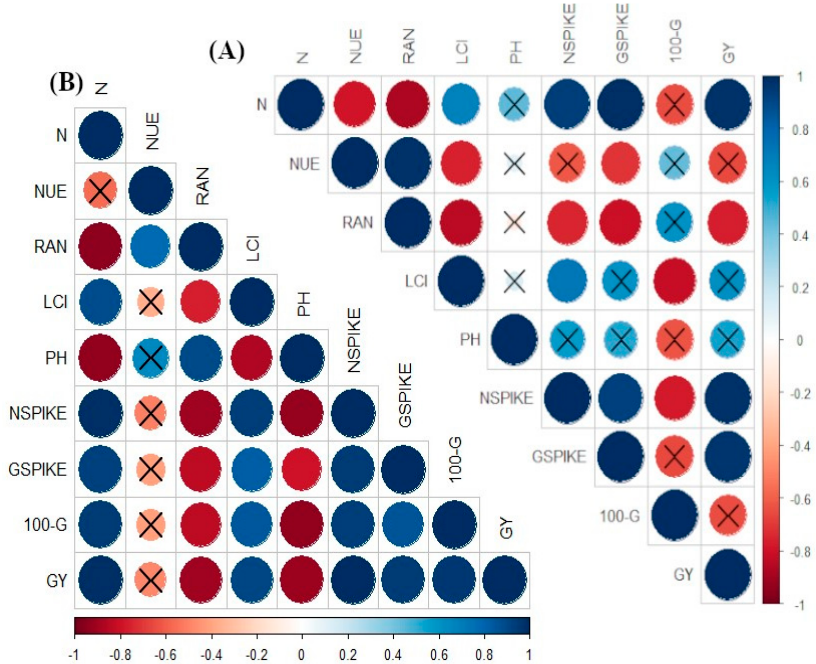
Figure 4. Heat-map color scale indicating Pearson’s correlation among evaluated parameters of wheat plants in response to N applications and diazotrophic bacteria inoculations in the 2016 ( A ) and 2017 ( B ) cropping seasons. X = indicates a non-significant relationship ( p < 0.05). Abbreviations: N = grain N accumulation, NUE = N use efficiency, RA N = recovery applied N, LCI = leaf chlorophyll index, PH = plant height, NSPIKE = number of spike m − 1 , GSPIKE = number of grain spike − 1 , 100-G = 100-grain weight, GY = grain yield.